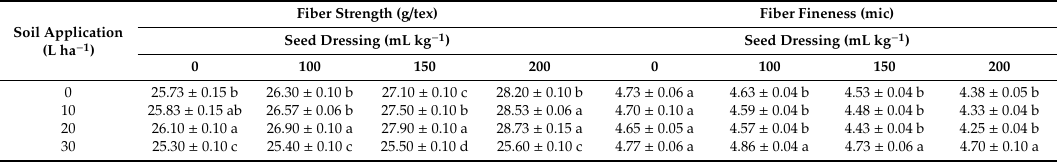
Table 4. The e ff ect of the soil applied and the seed dressed potassium humate on fiber strength and fiber fitness.